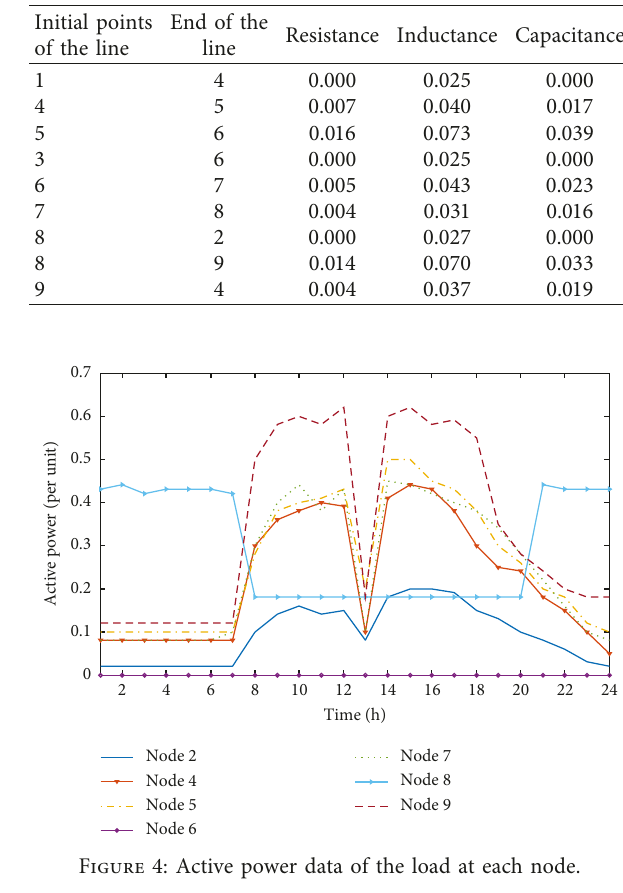
Table 2: Line parameters.